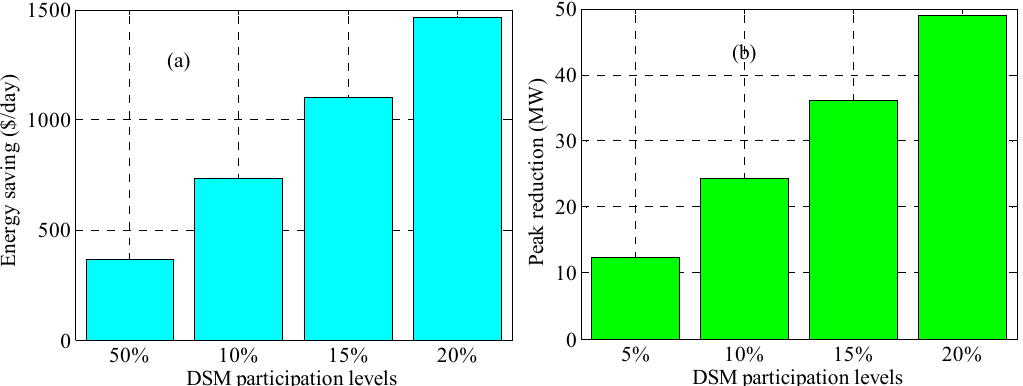
Figure 6. Frugality of public industry energy bill ( a ) and decline of peak load ( b ) by various levels of DSM participation.